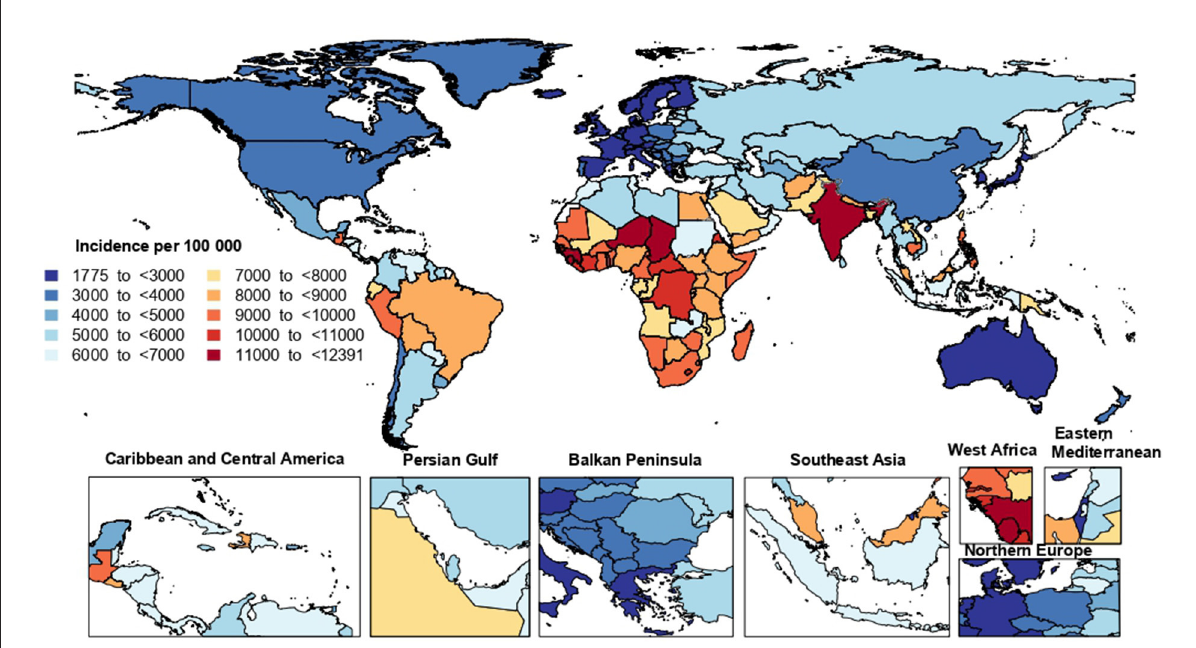
FIGURE1 Age-standardized incidence rate of lower respiratory infections (per 100,000 population) in 2019, by country (generated from data available from http://ghdx.healthdata.org/gbd-results-tool).